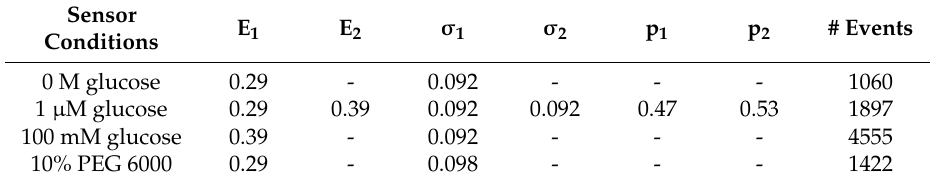
Table A1. Overview on the parameters obtained from histogram fittings of the dye-equipped MglB glucose sensor under different conditions as shown in Figure 2. E 1 and E 2 represent the means of the energy transfer efficiency values of the two resolved populations, σ 1 and σ 2 are the related widths, and p 1 and p 2 are the statistical weights of the first and second Gaussian, respectively. The “# Events” give the number of bursts which were considered to build the respective histogram.